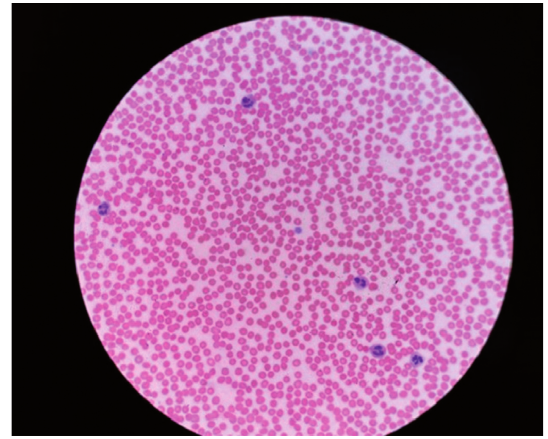
Figure 2: Peripheral smear with rare, large